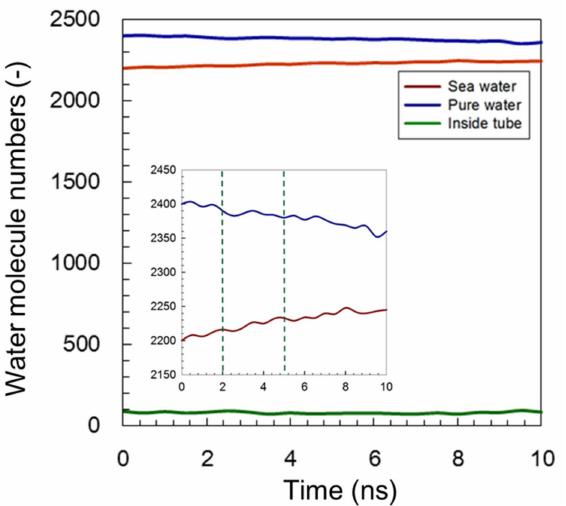
Figure 5. Time course for the number of water molecules during FO simulation with a modified C3deOAmBEr channel ( d = 18 Å). Inserted figure shows the enlarged vertical